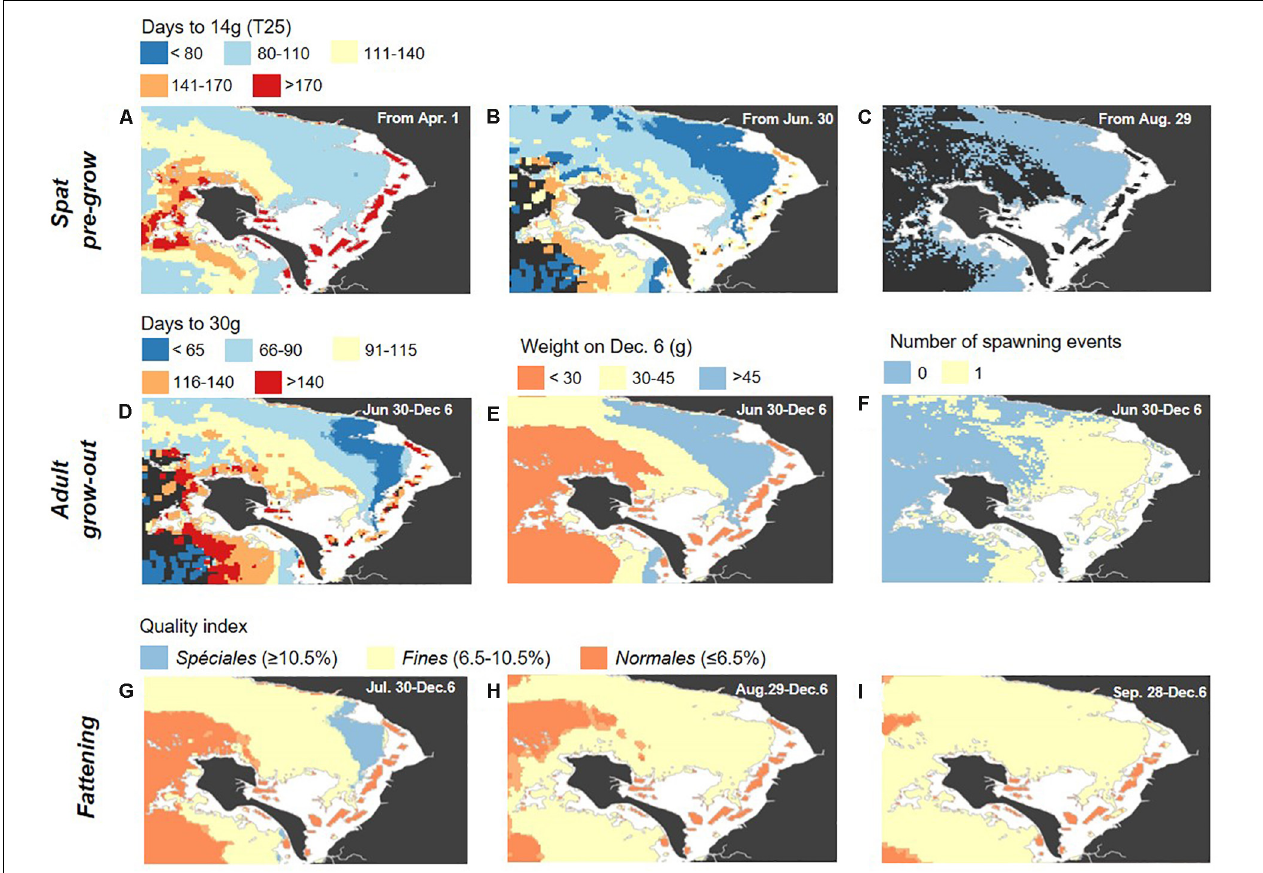
FIGURE 7 | Maps of the nine-year interannual means for the scenarios and growth indicators detailed in Table 3 , for the spat pre-growing phase (A–C) , from an initial T6–T8 (0.5 g) size, adult grow-out phase (D–F) , from an initial T25 (14 g) size, and final fattening phase (G–I) , from an initial Caliber 3 Normale size (76 g; QI = 6%). Note that dark gray water areas in a-d correspond to areas where the target weight (i.e., 14 g for spat and 30 g for adults) was not achieved by the end of the growing season.